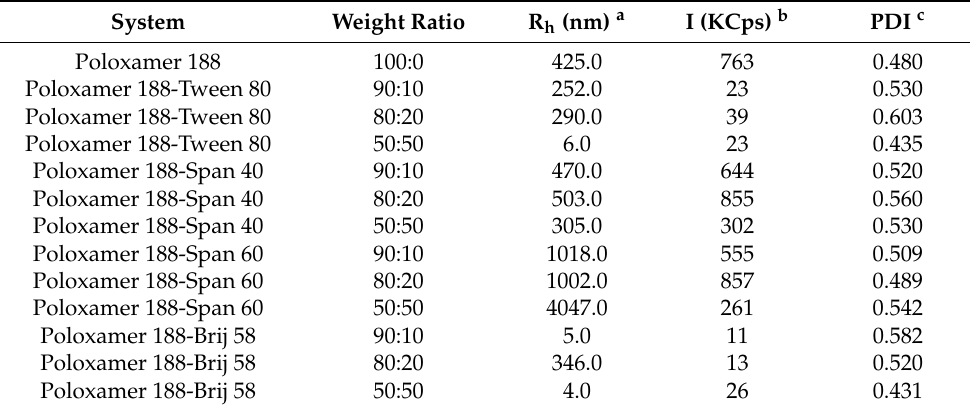
Table 1. The physicochemical characteristics of the prepared nanosystems.